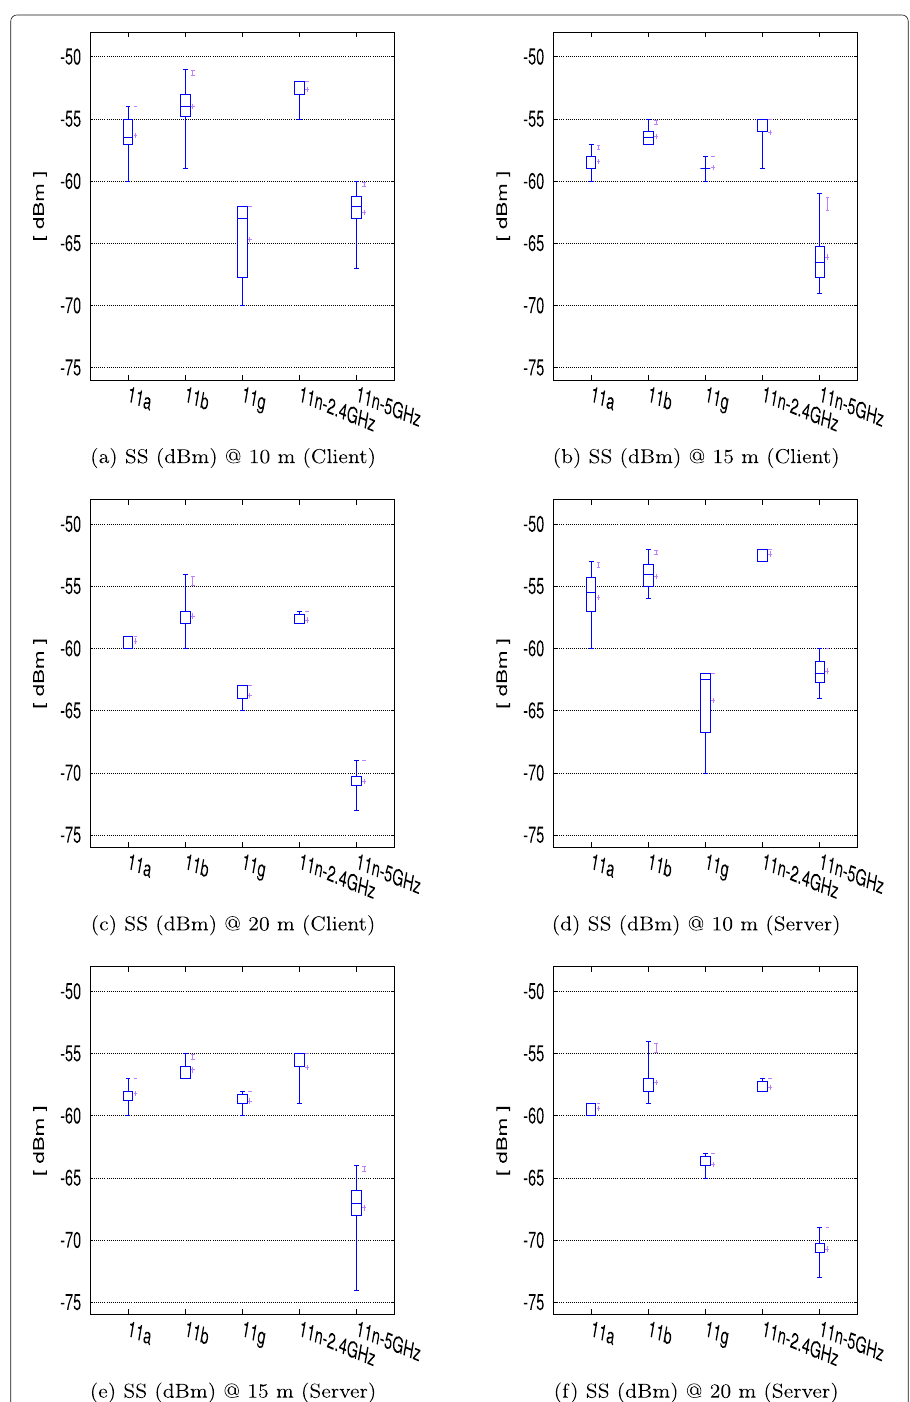
Fig. 5 Signal strength (SS) of 802.11 standards @ 10, 15, and 20 m for both client and server